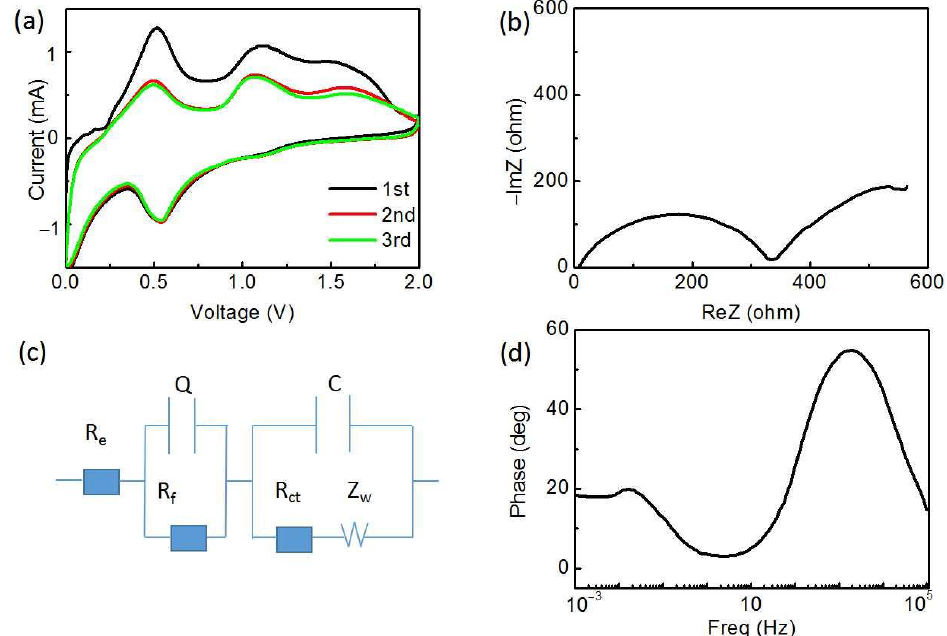
Figure 11. ( a ) Cyclic voltammetry curves, ( b ) Nyquist plots of the Ge composite, ( c ) equivalent circuit, and ( d ) the relationship between phase and frequency.